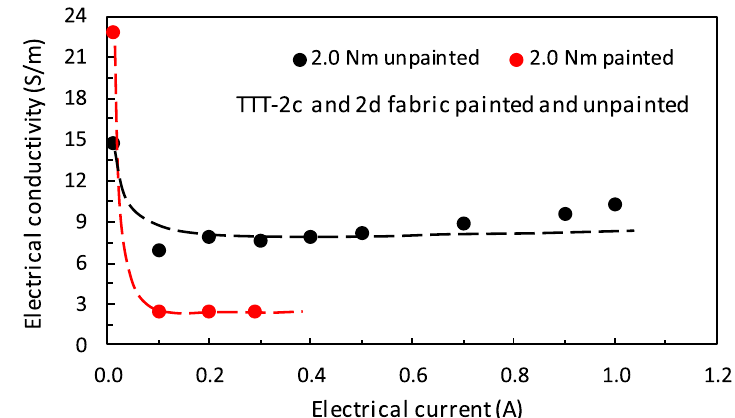
Fig. 5 Through-the-thickness electrical conductivities of carbon/epoxy laminates